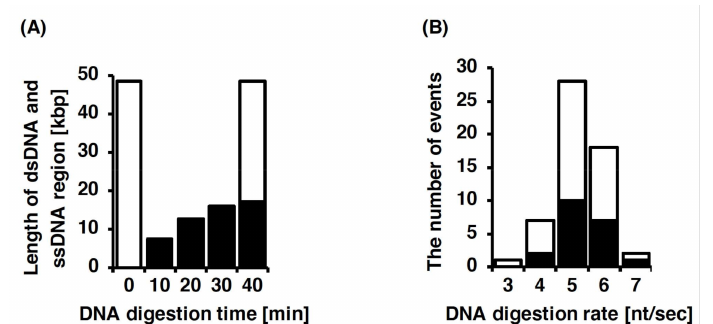
Figure 9. Analysis of the single-molecule imaging of the exonuclease activity on single DNA molecules. ( A ) Time course for the length of the double-stranded region and single-stranded region of a single DNA molecule during DNA digestion by T7 exonuclease. White bars indicate the length of the double-stranded region in single DNA molecule stained with SYTOX Orange. Black bars are the length of the single-stranded region digested by T7 exonuclease stained with fluorescently labeled ssDNA-binding protein. Sum of the lengths of single- and double-strand regions agreed with that of the undigested DNA at 40 min of DNA digestion time. ( B ) Histogram of the DNA digestion rates for T7 exonuclease. White bars and black bars indicate the results determined from single-molecule imaging of DNA digestion under pulse-chase conditions and under continuous conditions with T7 exonuclease. Refer to [174] for